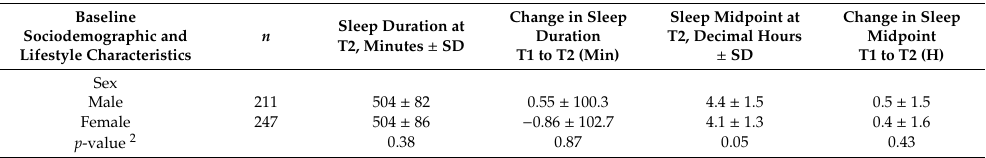
Table 1. Sleep characteristics at T2 and change in weekday sleep characteristics from T1 to T2, stratified by baseline sociodemographic and lifestyle